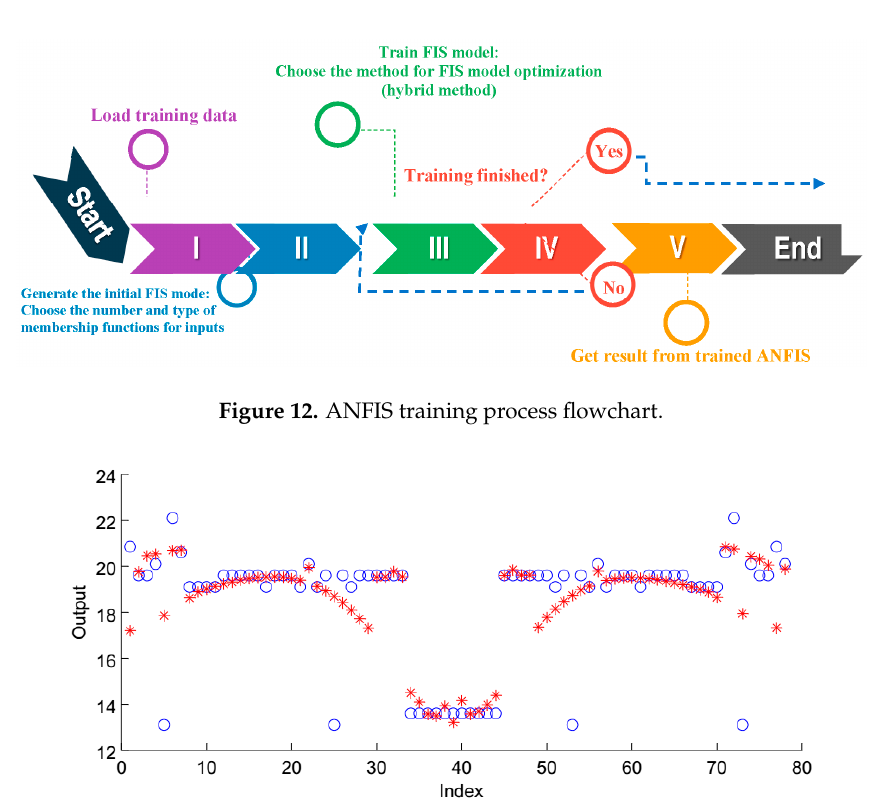
Figure 13. Approximation of training data and fuzzy output (O and * are symbols representing the trained data and FIS output respectively).